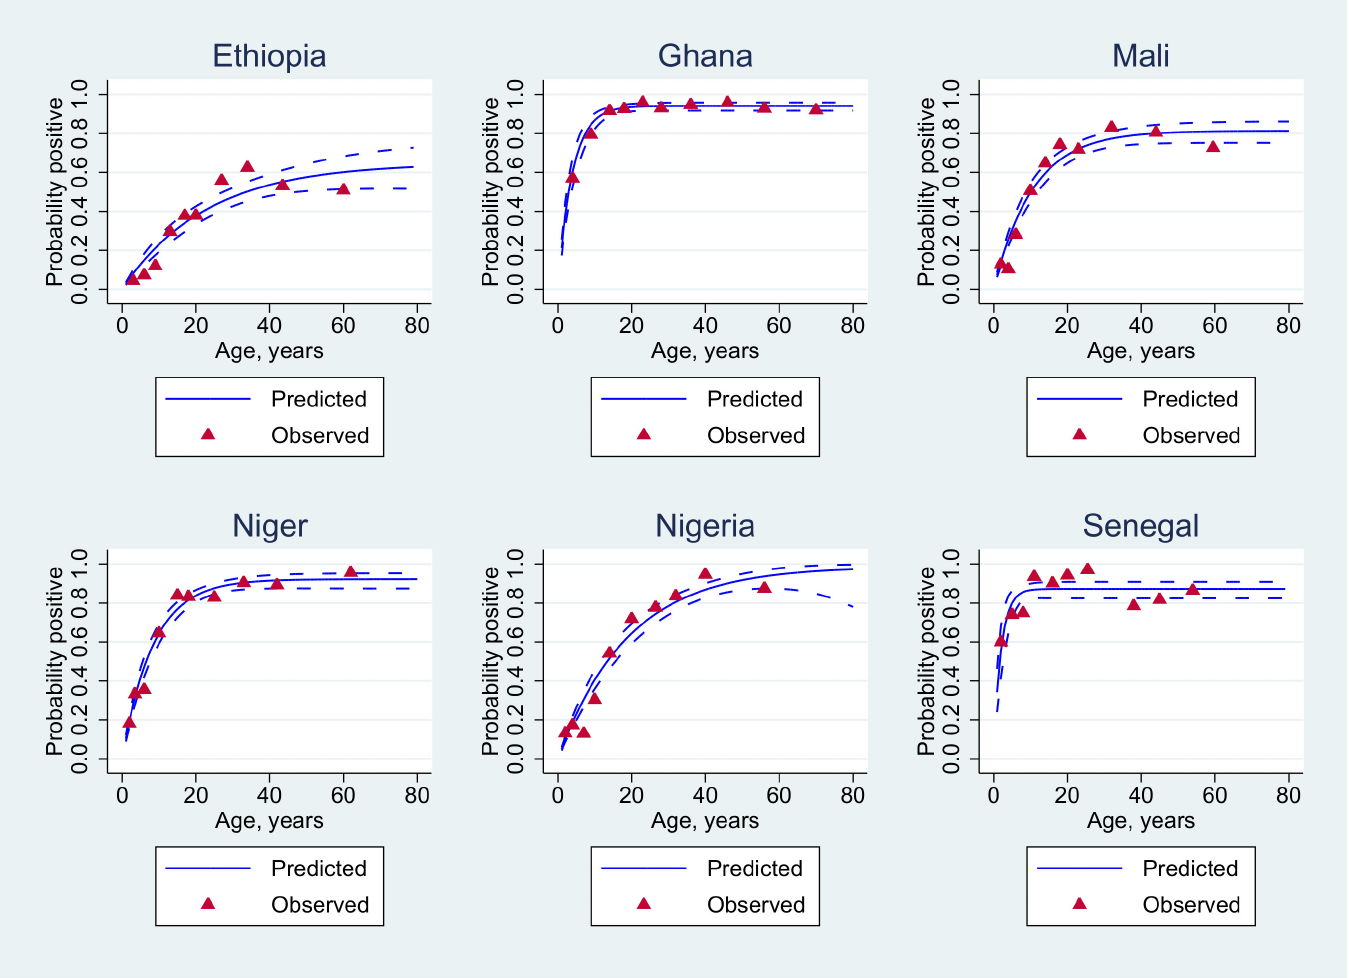
Fig 2. Statistical analysis of seropositivity data for all individuals. Age-adjusted seroprevalence (blue solid lines) using appropriate reversible catalytic models. The observed seroprevalences (red-filled triangles) were pooled according to the 10%-centiles of the underlying age distribution.